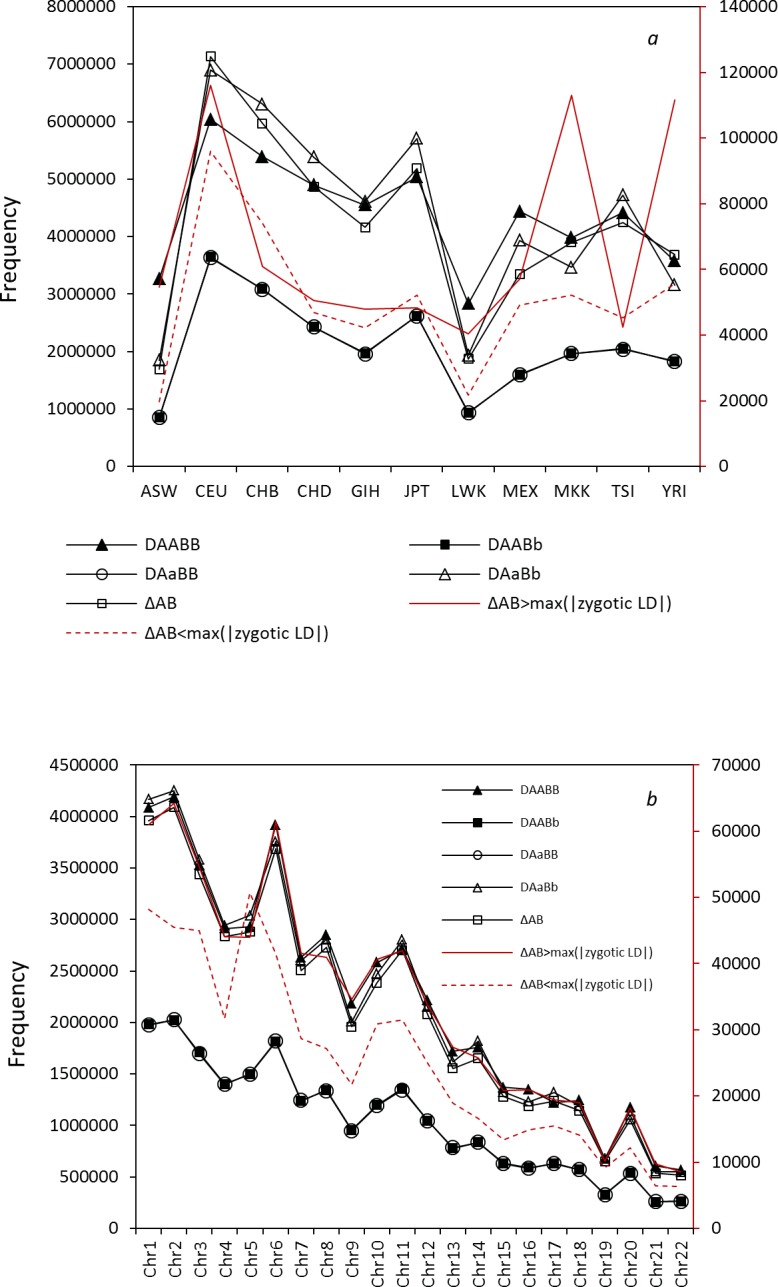
Total SNP pairs of the significant zygotic LDs, the significant composite digenic LDs, and the significant differences between the composite digenic and maximum zygotic LDs.(a) for each population over all autosomes; (b) for each autosome over all populations. The primary y-axis is used for all black lines while the secondary y-axis is used for the red solid and dashed lines.